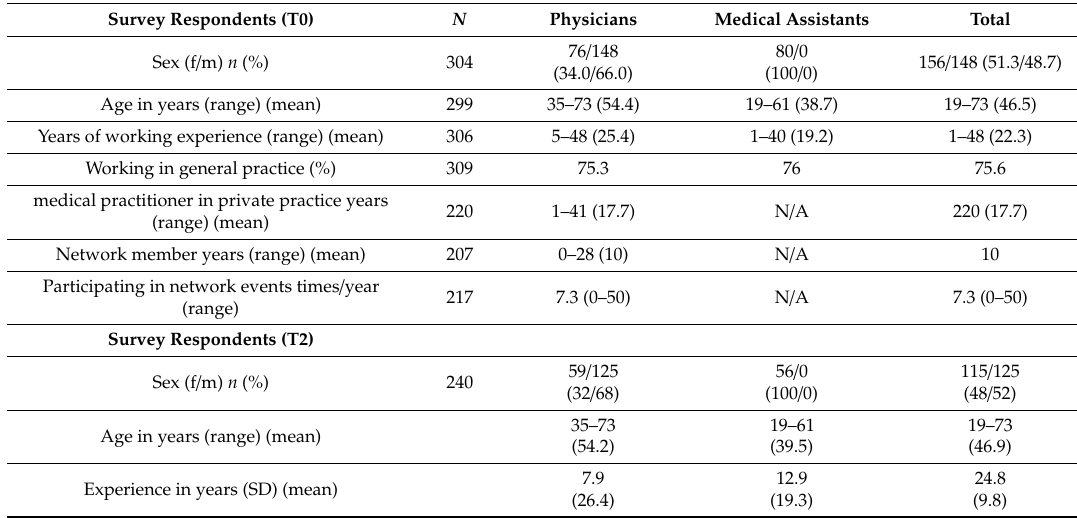
Table 1. Characteristics of survey respondents for measuring points T0 and T2.